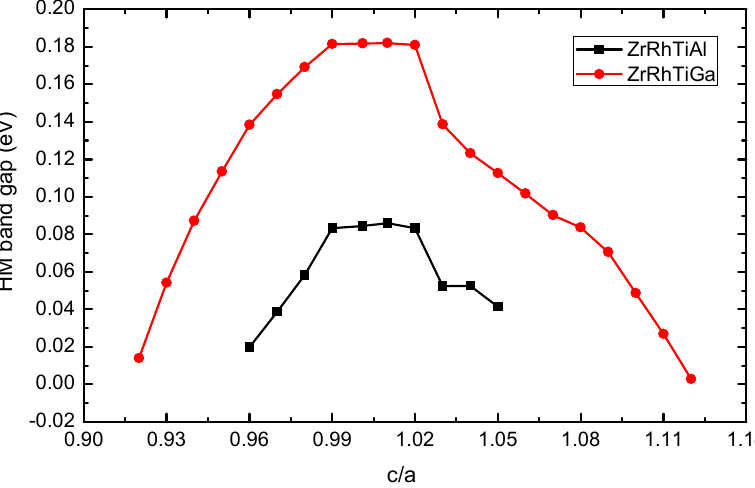
Figure 13. The half-metallic band-gaps as functions of the c/a ratio (TD) for ZrRhTiAl and ZrRhTiGa.